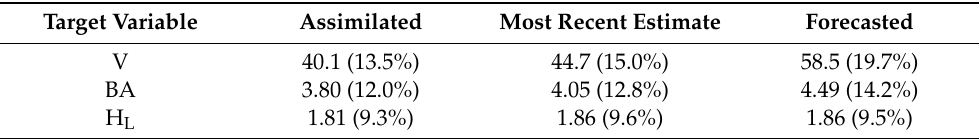
) from the field measurement 2011 for the nine assimilated plots. Table 5. Mean deviation ( A positive means that the value is on average overestimated compared to the field 𝑅𝑅𝐷𝐷 measurements. In parentheses is relative 𝑅𝑅𝐷𝐷